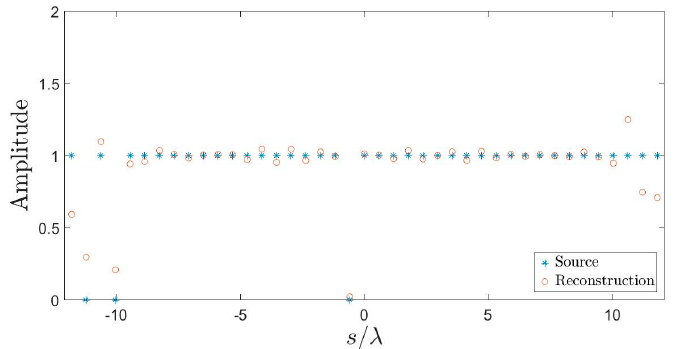
Figure 14. Reconstruction of a 41-element array with two faulty elements. The number of array elements is smaller than the one estimated by (17) as the source NDF (45).